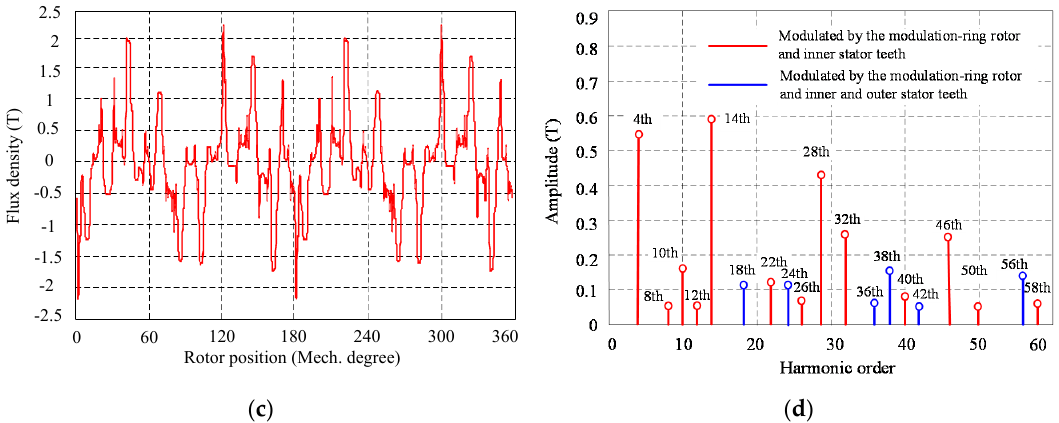
Figure 3. Magnetic flux density with on-load: ( a ) Flux density of inner air-gap; ( b ) Harmonic order of flux density of inner air-gap; ( c ) Flux density of outer air-gap; and ( d ) Harmonic order of flux density of outer air-gap.